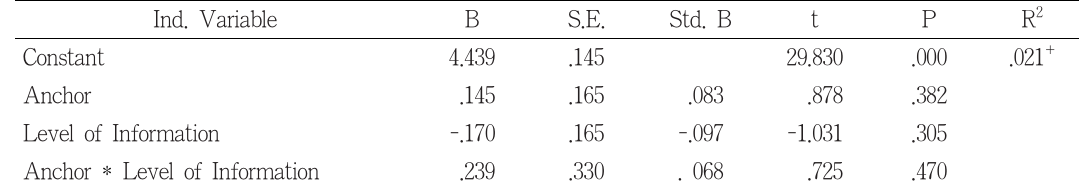
<Table 5> Interaction Effect of Information Level on WTP